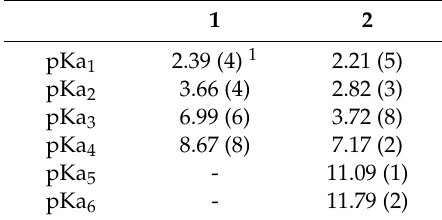
Table 1. Protonation and acidity constants of 1 and 2